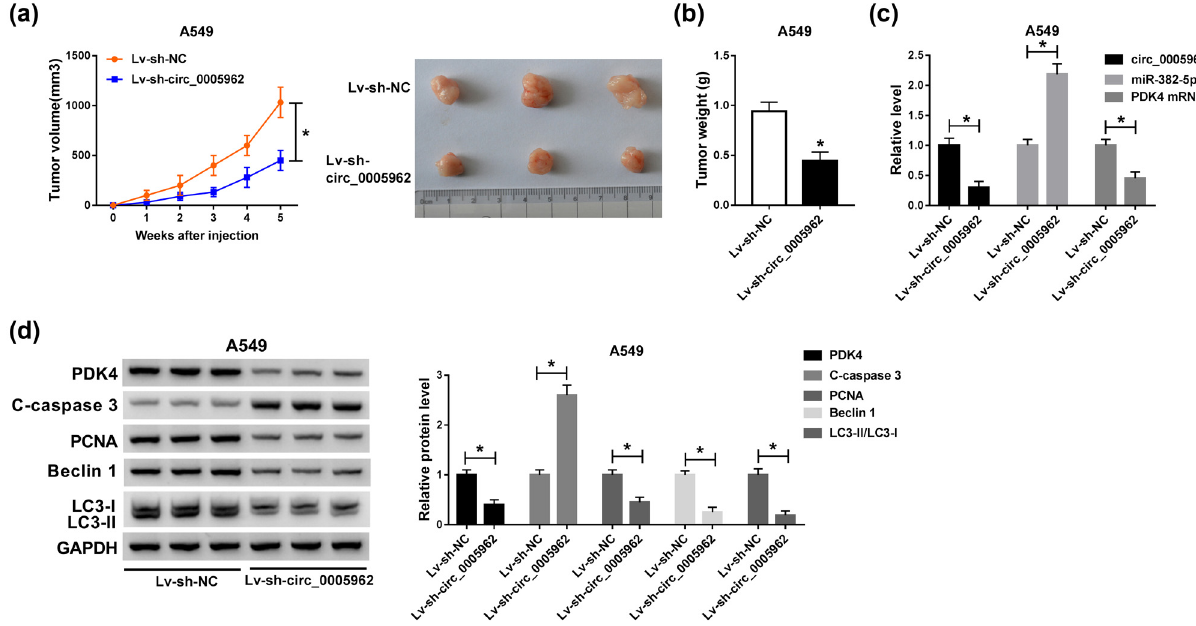
Figure 7: circ_0005962 knockdown depleted tumor growth in vivo . ( a ) The tumor volume was recorded once a week, lasting 5 weeks. ( b ) The tumor weight was measured after 5 weeks. ( c ) The expression of circ_0005962, miR - 382 - 5p, and PDK was examined in excised tumor tissues by qPCR. ( d ) The protein levels of PDK4, C - caspase 3, and PCNA were quanti fi ed by western blot. * P <